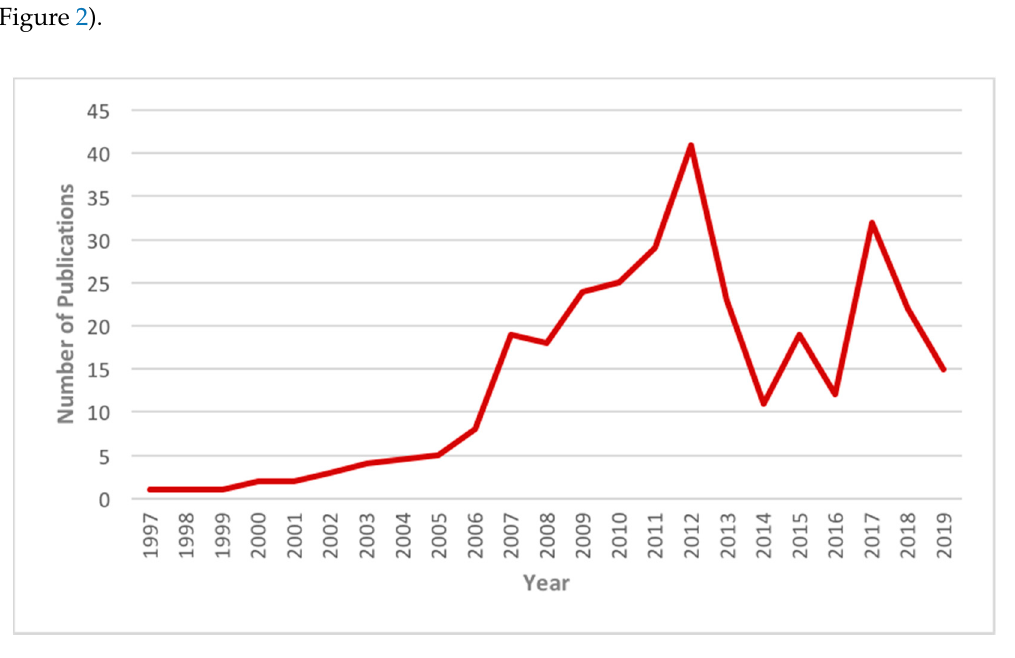
Figure 2. Number of articles published on renewable energies and sustainability.